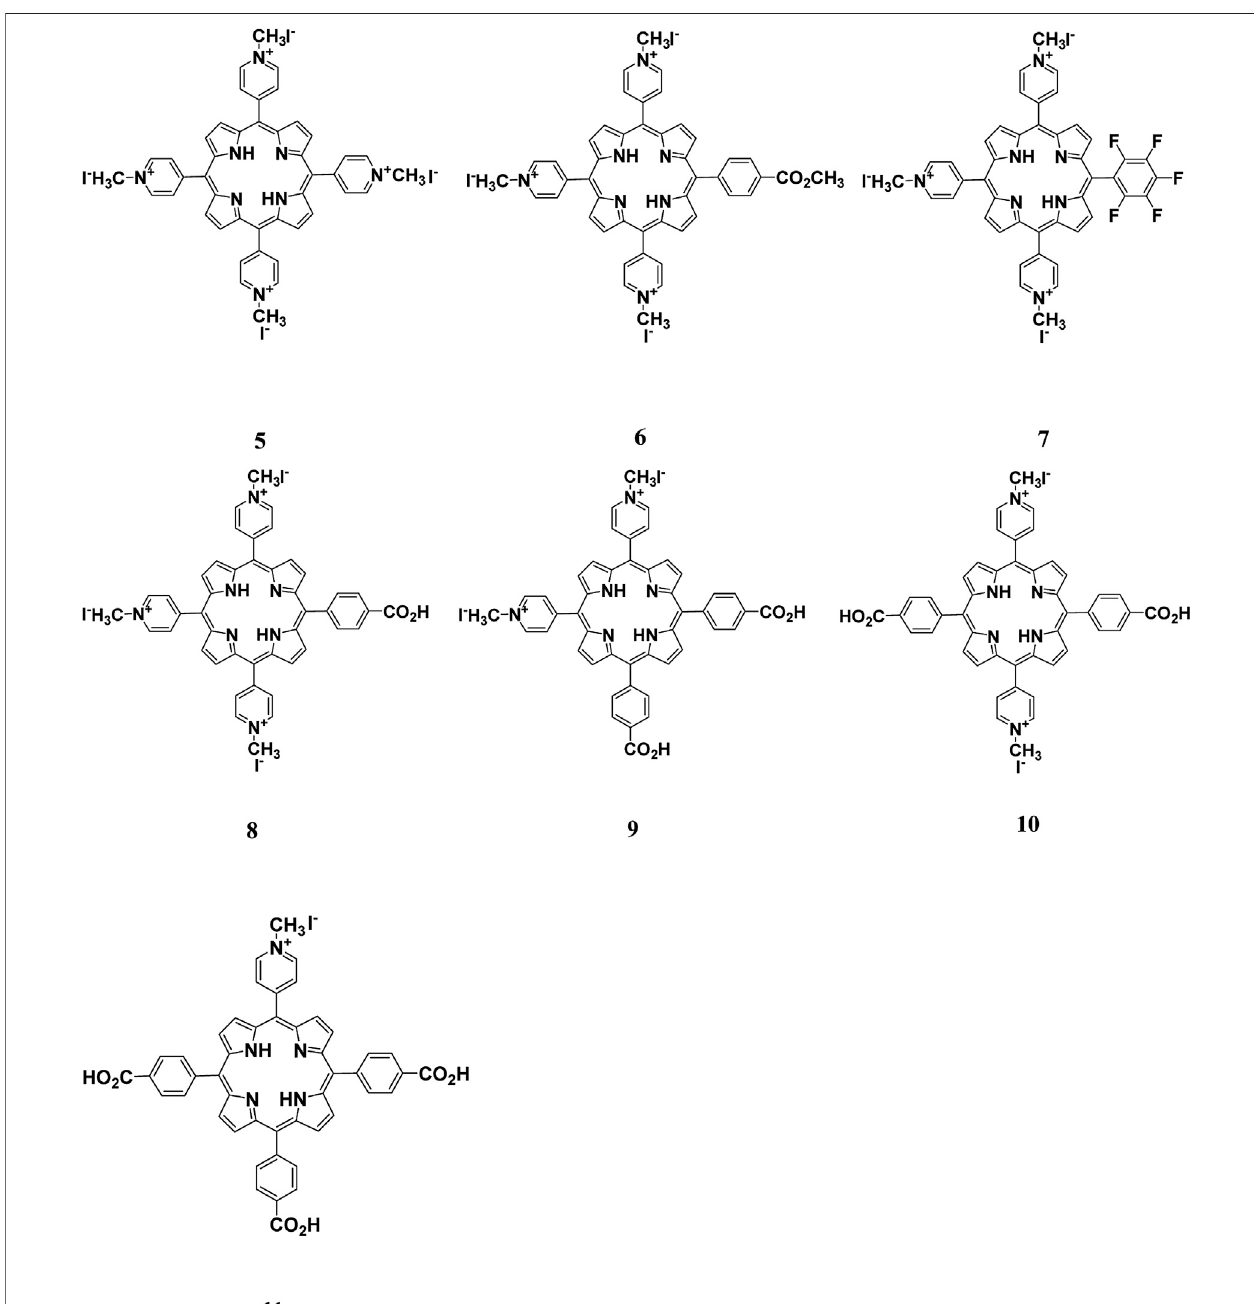
FIGURE3| Cationicporphyrinderivativesemployedforphotoinactivationofbacteria.Quaternizationoftheporphyrinsresultedinsystemswithhighpositivecharge density. Highly cationic systems were found to have enhanced antimicrobial activity. The positive charge was found to enhance the binding of the system to negatively charged bacteria leading to bacteria destruction. Reproduced with permission from Alves et al.